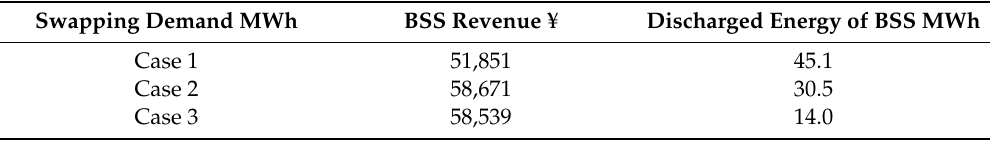
Table 6. The influence of swapping demand on BSS.